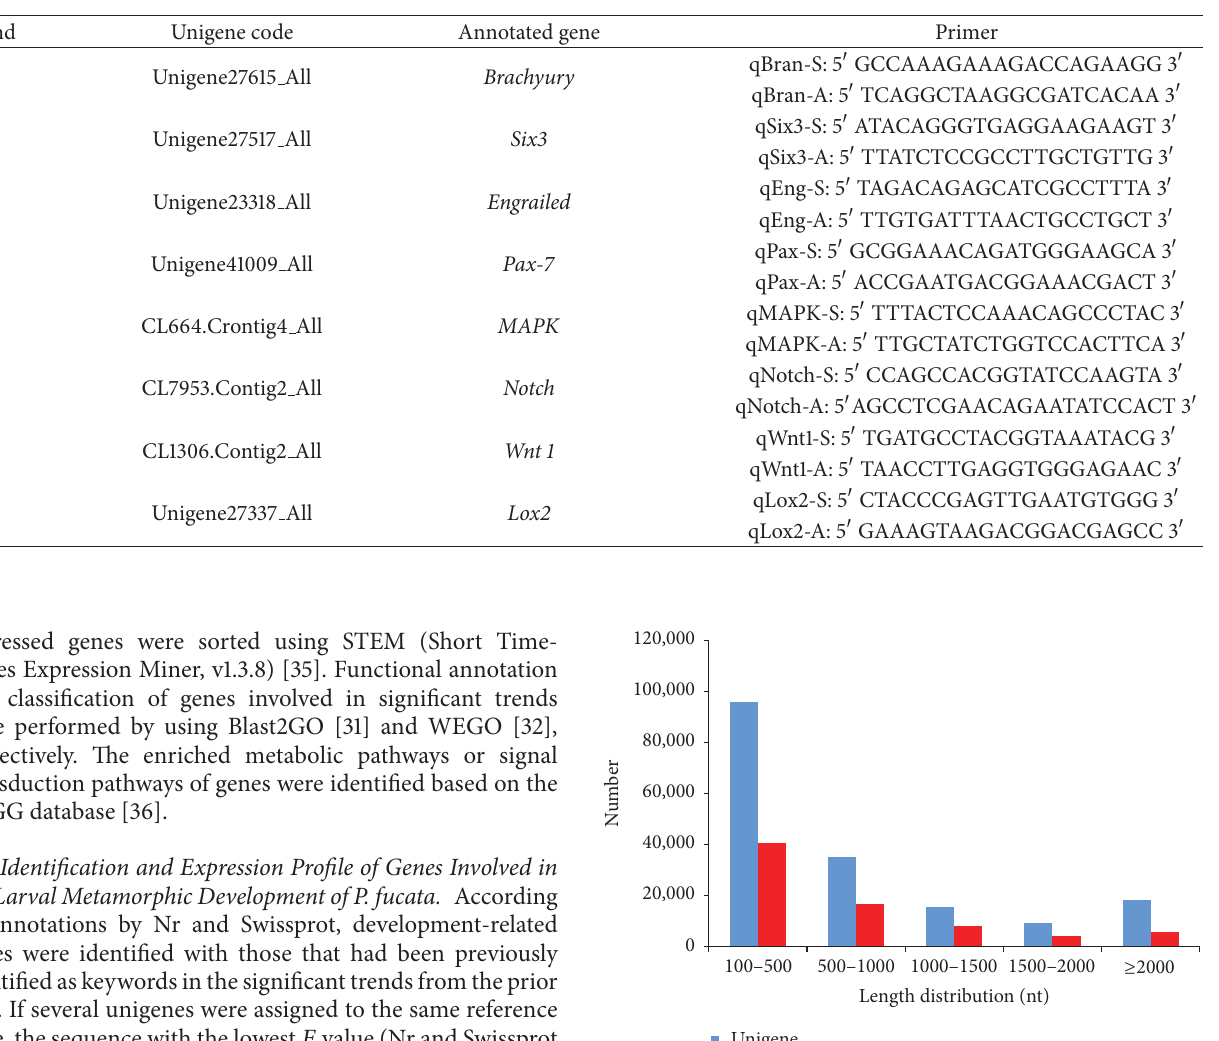
Table 1: Primers for genes used for qPCR verification.